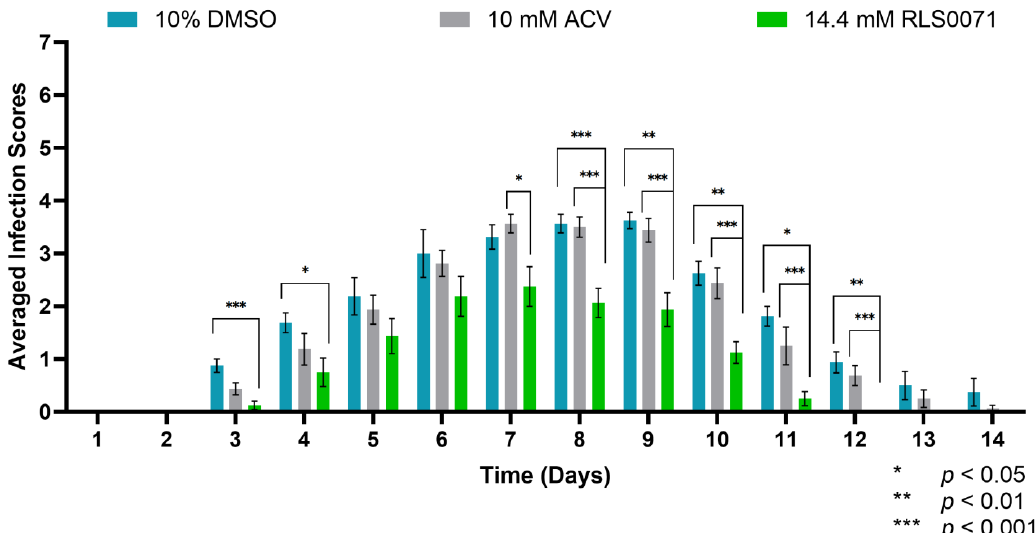
Figure 3. ACV R -HSV-1 infection scores of BALB/cJ mice following the application of 10% DMSO, 14.4 mM RLS-0071, or 10 mM ACV in 2.5% HEC gel (N = 8/group). Age-matched BALB/cJ mice were inoculated with 2.0 × 10 5 PFU of ACV R - HSV-1 and treated. The mice were monitored for 14 days, and the averaged infection scores of animals in each treatment group were recorded. RLS-0071-treated BALB/cJ mice demonstrated a significant reduction in the appearance of vesicles compared to DMSO-treated animals. Mixed-model ANOVA and multiple comparison tests (Interactions (Time*Treatment): ( p = 0.0017); Treatments (DMSO/RLS0071/ACV): ( p < 0.0001); and Time (days): ( p < 0.0001)); * p < 0.05; ** p < 0.01; *** p < 0.001. All error bars represent